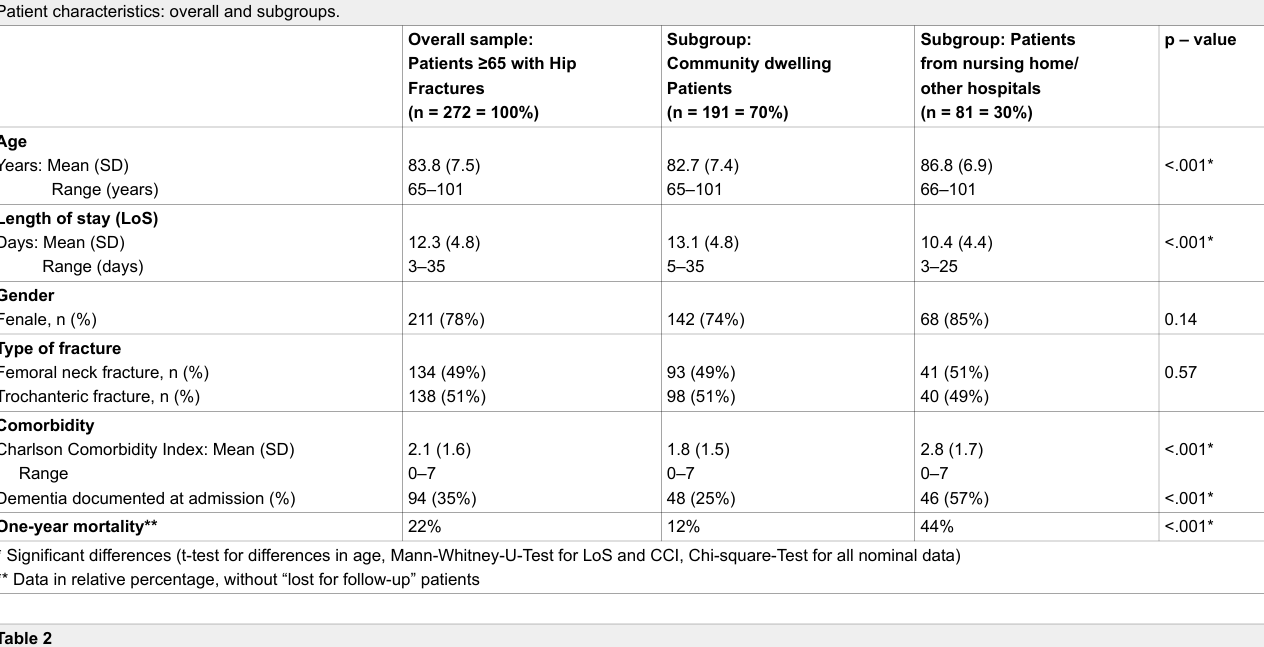
Subgroup: Patients from nursing home/